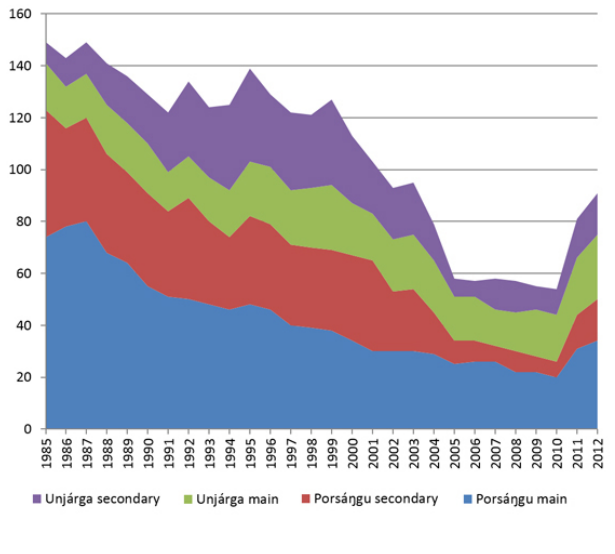
Fig. 2 . Registered fishers in Unjárga and Porsá η gu, 1985-2012, main and secondary occupation. Source: Directorate of Fisheries